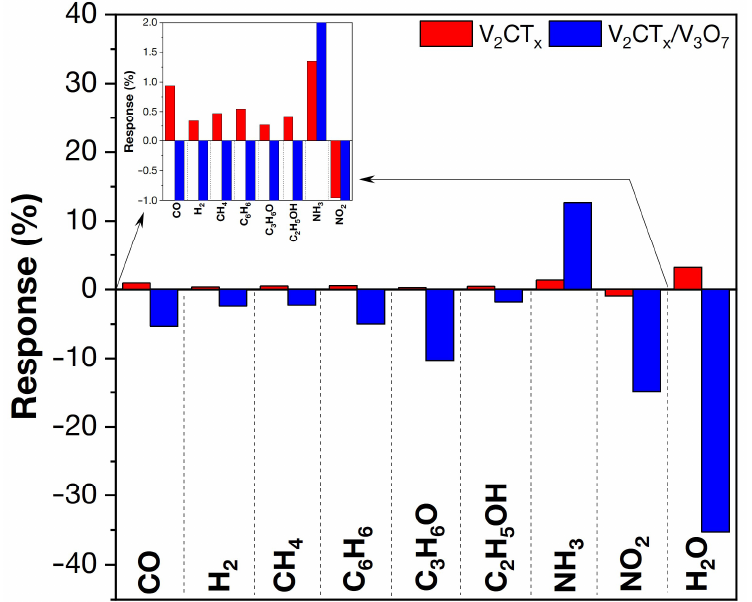
Figure 8. The selectivity diagram of V 2 CT x MXene film and V 2 CT x /V 3 O 7 nanocomposite summariz- ing the response data (taking into account the sign of response, i.e., the direction of resistance change. The “+” sign corresponds to an increase in electrical resistance, and the “ − ” sign to a decrease) for different gases (100 ppm CO, NH 3, NO 2 , C 6 H 6 , C 3 H 6 O, C 2 H 5 OH, 1000 ppm CH 4 , H 2 and 20%RH), with the inset with a large increase in response value for some gases.